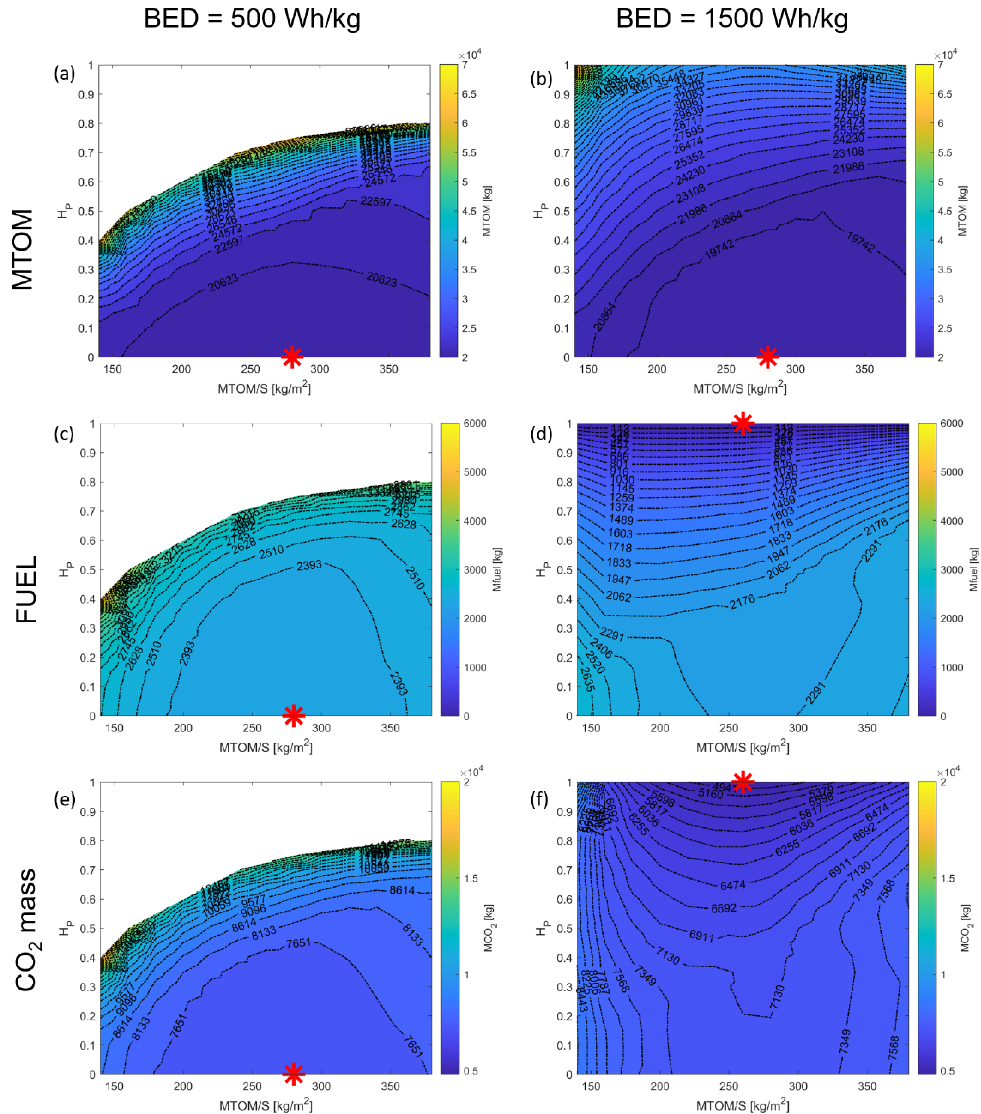
Fig. 12. MTOM, duel burnt and CO 2 production for box-wing con fi guration with BED =500 Wh/kg (left) and BED =1500 Wh/kg